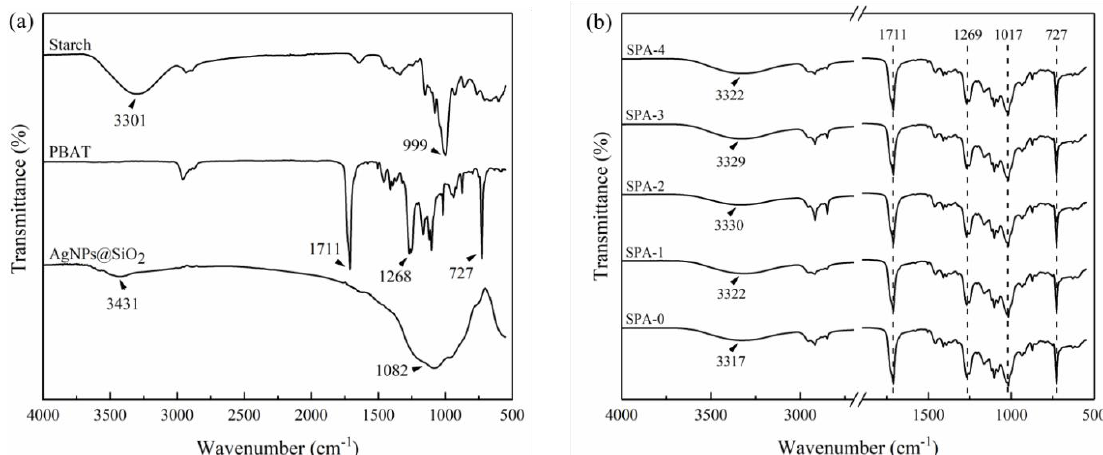
Figure 3. ATR-FTIR spectra of ( a ) starch, PBAT, and AgNPs@SiO 2 ; and ( b ) starch/PBAT antibacterial films loaded with different levels of AgNPs@SiO 2 .